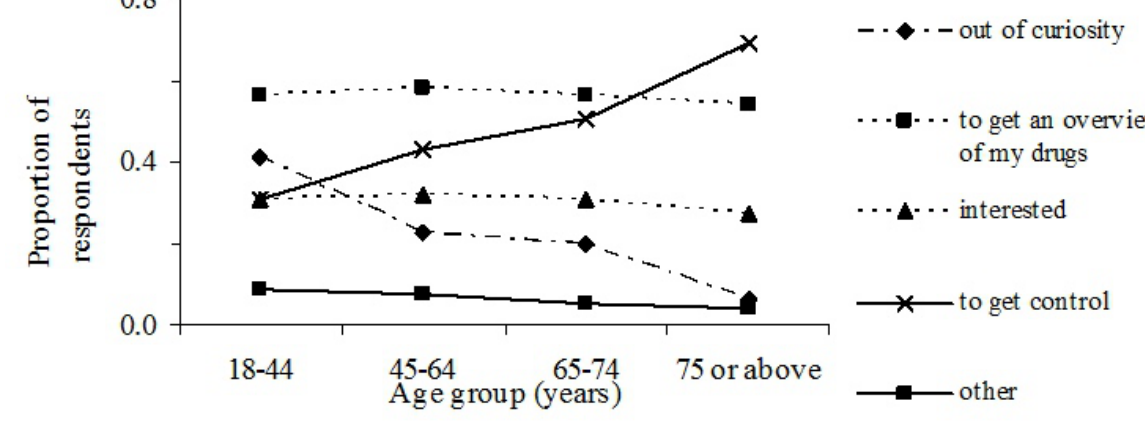
Figure 2. Frequency distribution of respondents’answers to the question, “ Why did you take a look at ‘My dispensed medications’?”